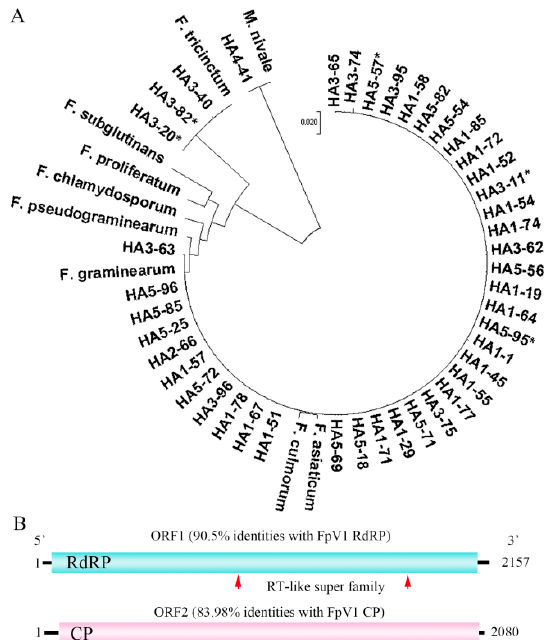
Figure 1. Phylogenetic analysis of Fusarium strains that isolated from Huai’an in 2021 and genomic organization of FpV1 ‐ Fa virus. ( A ) A phylogenetic analysis of the concatenated sequences of about 530 nt ITS is performed with the use of NJ method in the MEGA 6.0 program. The scale bar represents a genetic distance. The GenBank accession numbers of reference sequences are as follows: KX066046.1 ( F. graminearum ), NR_121320.1 ( F. asiaticum ), LC13674 ( F. proliferatum ), LC13682 ( F. subglutinans ), BBA62170 ( F. chlamydosporum ), NRRL28062 ( F. pseudograminearum ), EU214562.1 ( F. culmorum ), KU350729.1 ( F. tricinctum ) and MG891797.1 ( Microdochium nivale ). The isolates containing FpV1 ‐ Fa are shown with asterisks. ( B ) Genomic organization of FpV1 ‐ Fa virus. The open reading frame (ORF) and the untranslated regions (UTRs) are indicated by a rectangular box and a single line, respectively. The identities between Fusarium poae virus 1 (FpV1) and FpV1 ‐ Fa are marked on top.